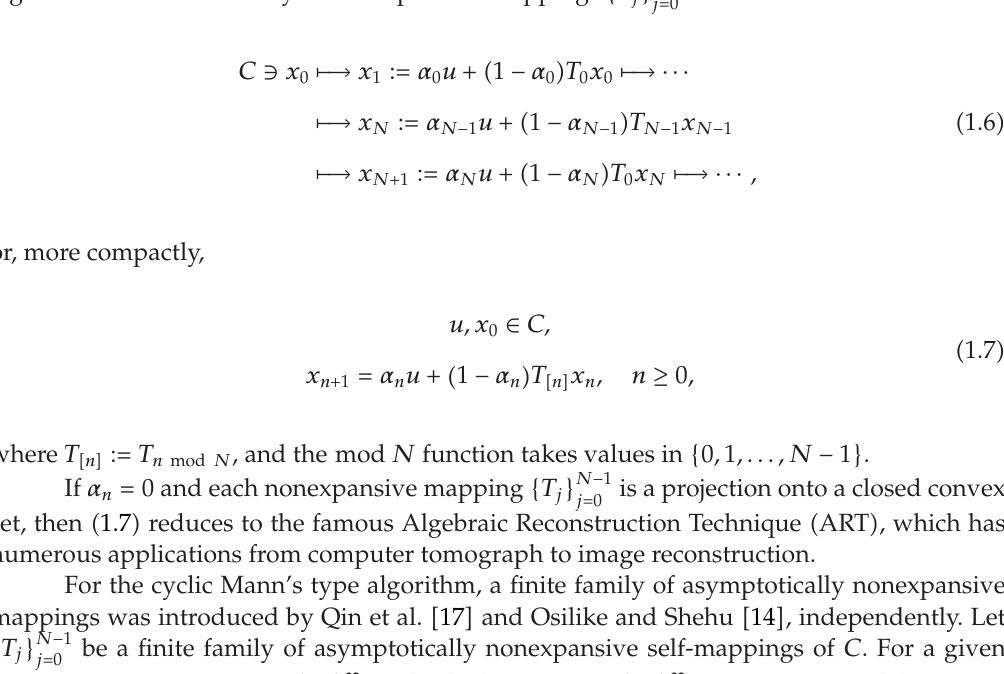
algorithm for a finite family of nonexpansive mappings { T j }